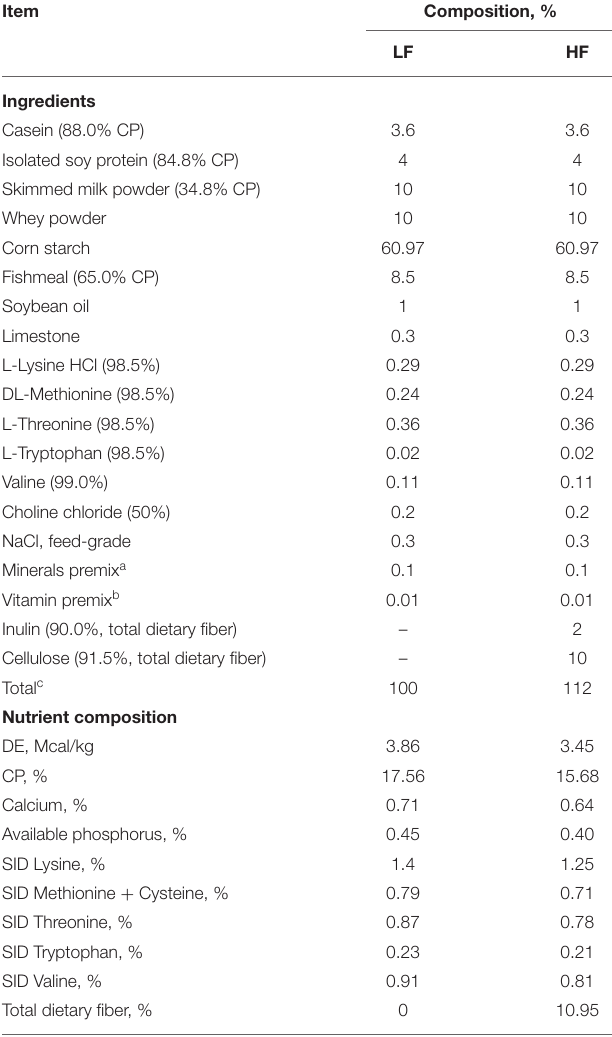
TABLE 1 | Ingredients composition and nutrient level of the diet (as-fed